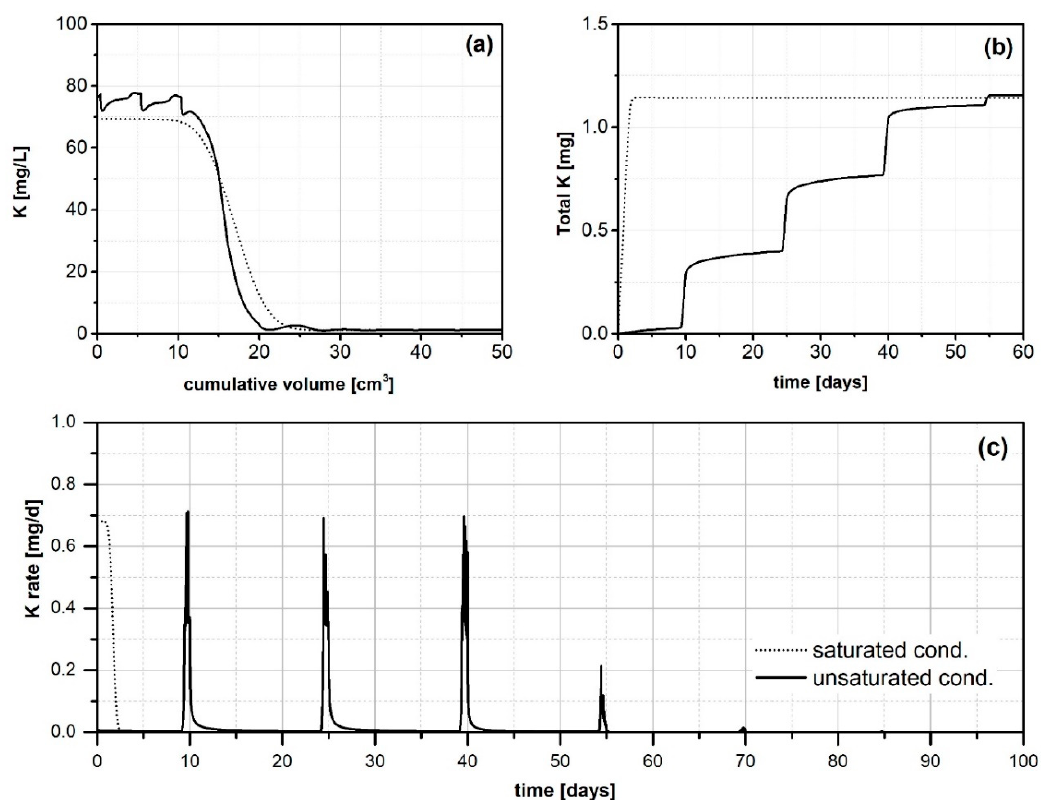
Figure 5. Comparative evaluation for saturated and unsaturated flow conditions using the E.E. ap- proach: ( a ) potassium concentration versus cumulative water volume, ( b ) accumulated potassium mass and ( c ) potassium release rate.